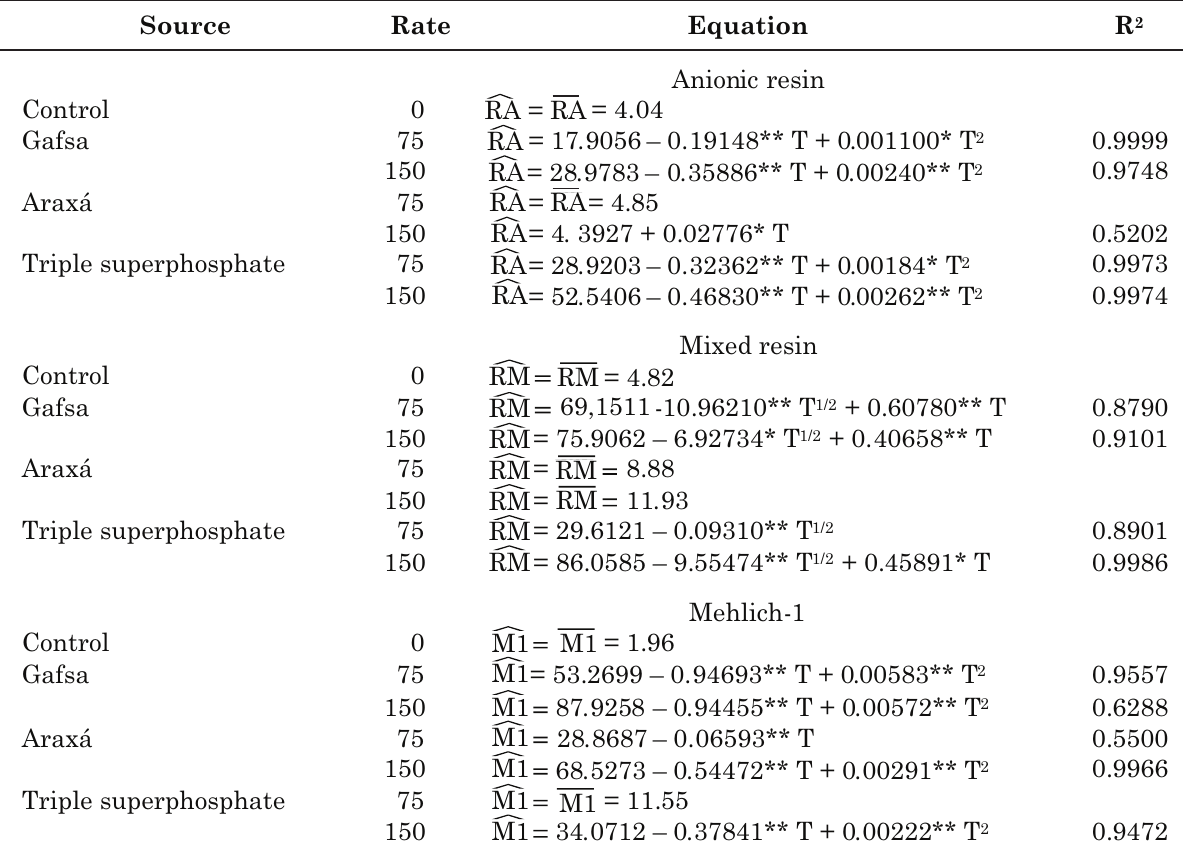
Table 4. Equations for the P contents (mg dm -3 ) by the extractants: Anionic resin (AR), Mixed resin (MR) and Mehlich-1 (M1), in function of the contact time (T, in days) with a very clayey Red Latosol (LV), after applying P sources at different